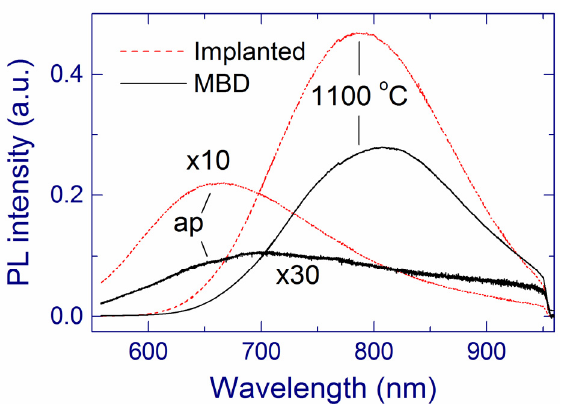
Figure 9. PL spectra of as-prepared (ap) and annealed (1100 °C) SiO 1.8 films fabricated